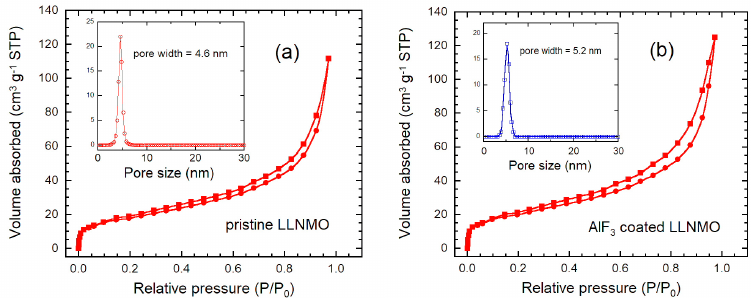
Figure 5. N 2 adsorption desorption isotherm and Barrett–Joyner–Halenda (BJH) pore-size distribution for ( a ) pristine and ( b ) AlF 3 -coated Li 1.2 Ni 0.2 Mn 0.6 O 2 oxides. Table 3. Brunauer–Emmett–Teller (BET) specific surface area, calculated average particle size from BET data ( L BET ) using Equation (2), mean particle size measured using TEM imaging ( L TEM ) and results